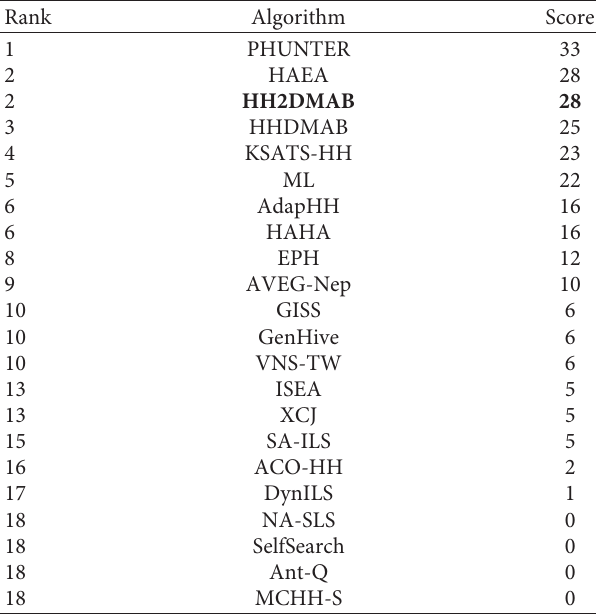
Table 6: Comparison with CHeSC 2011